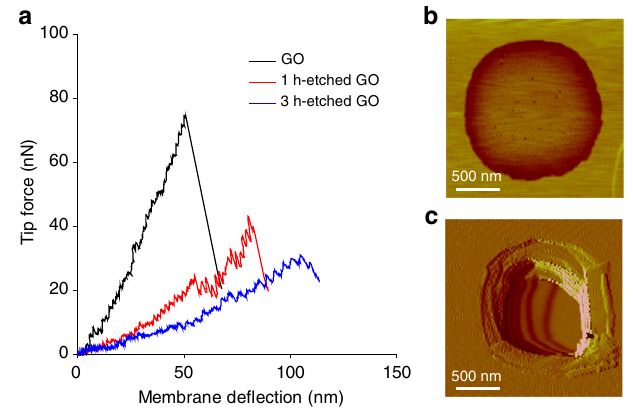
Fig. 2 Nanomechanical characterization for pristine and porous GO single layers. a Representative force-de fl ection curves obtained by membrane- de fl ection experiments using a diamond AFM probe, suggesting etched sheets become softer and weaker as etching time increases. The 5-h- etched GO sheets are too weak to be measured. Representative AFM images of 3-h-etched GO prior to de fl ection experiments show visible pores in b , and complete rupture of the membrane after the test in